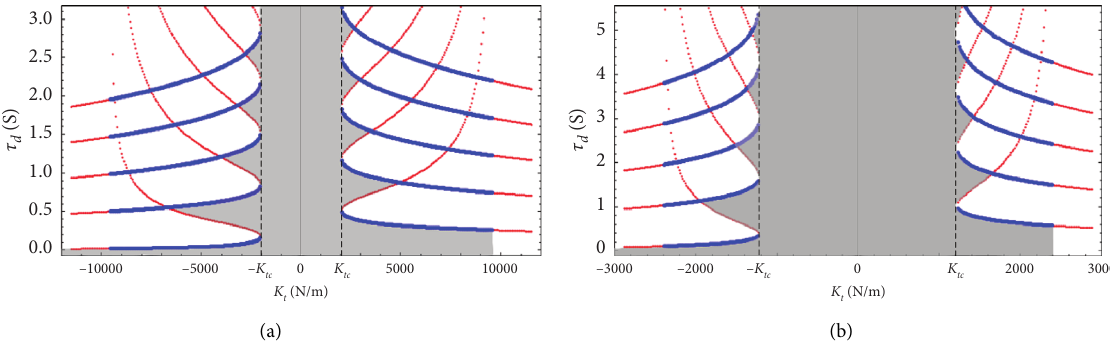
Figure 5: The skeleton for stability switches on the parameter plane of the time delay and control gain, indicating the feasible area (white) and infeasible area (gray) for chaotification when the system stiffness is (a) K